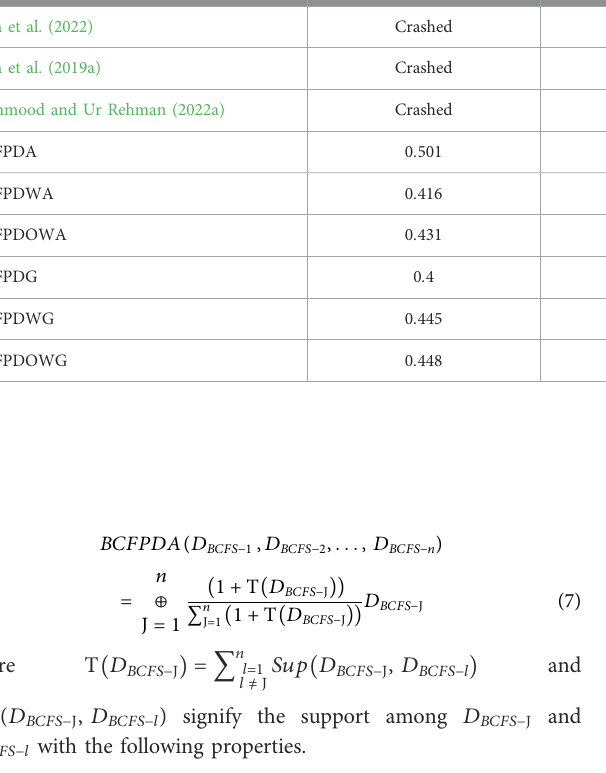
TABLE 13 Score values of the data given in Table 3 were achieved by using both our research and the existing results.